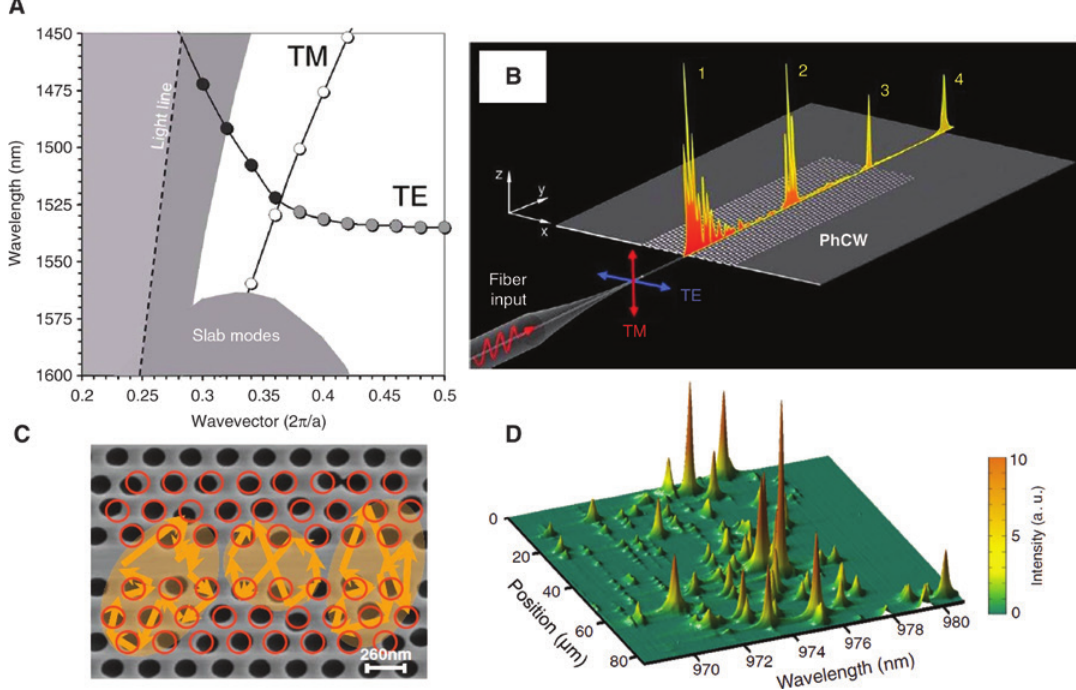
Figure 19: Disordered PhC structures that exhibit Anderson localisation of light. (A) Photonic band structure around the quasi-transverse electric (TE) mode edge showing both quasi-TE and quasi-transverse magnetic (TM) guided modes for a hexagonal PhC with air holes etched in the oxide layer of an SOI chip. (B) Excitation of high- Q random cavities in a tapered fibre-coupled W1 waveguide engineered in a PhC slab. Marked features in the surface emission (i.e. orange peaks) represent the scattered light intensity from Anderson-localised random cavities at (1) the input facet, (2) inside the waveguide, (3) at the waveguide output, and (4) at the cleaved facet. The TE and TM polarisation of the excitation beam are denoted by the blue and red arrow marks. Adapted from [130]. (C) PhC waveguide with 6% engineered disorder, wherein the holes in the ideal PhC structure without engineered disorder are shown as red circles and the wave vectors of localised modes point along the orange arrows. (D) Photoluminescence spectra collected from a 3% disordered sample at 10 K. The excitation and collection microscope objectives were scanned along the waveguide. Adapted from